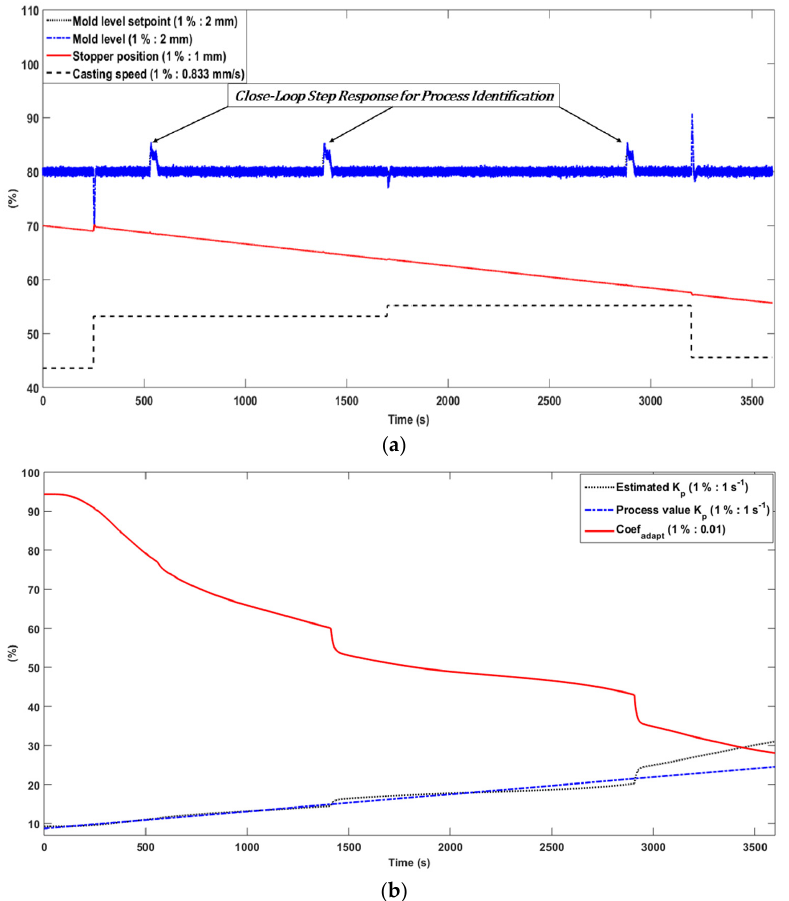
Figure 10. Simulation of adaptive mold level control for a cast with medium SR erosion: ( a ) mold level performance; ( b ) diagnostic and compensation of process gain change by valve erosion.